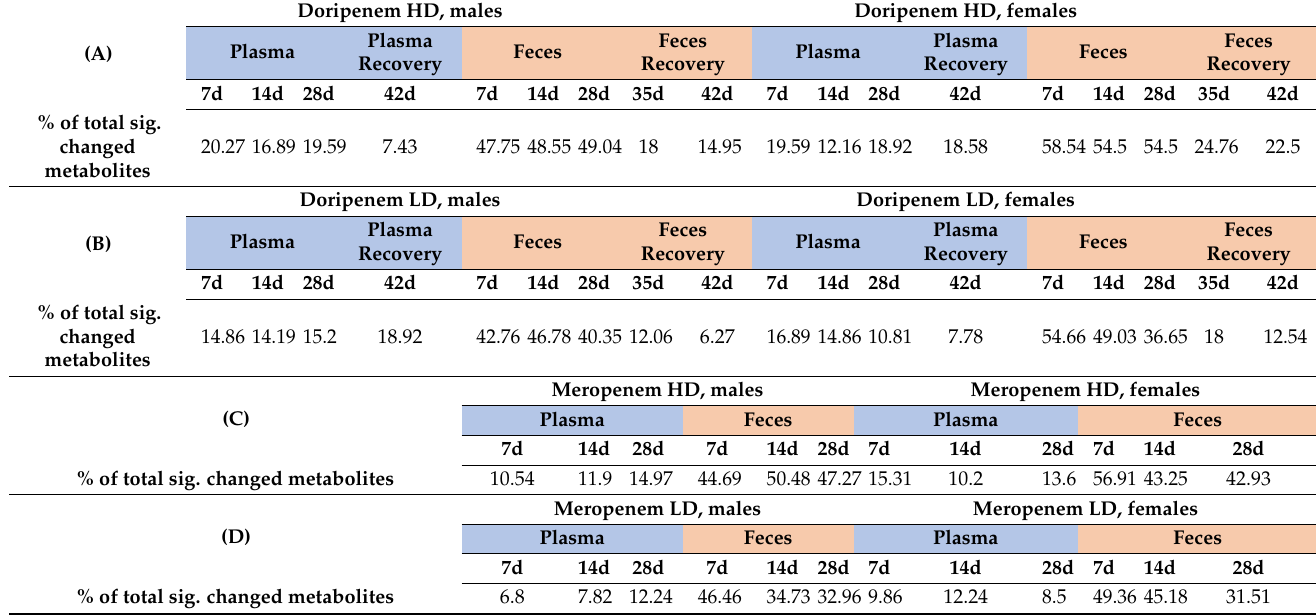
Table 14. Percentages of the total number of significantly changed plasma (in light blue) and fecal (in light orange) metabolites at a p -value < 0.05 for the ( A ) HD and ( B ) LD groups of doripenem treatment plus the doripenem-recovery group and ( C ) HD and ( D ) LD groups of meropenem treatment in both sexes,